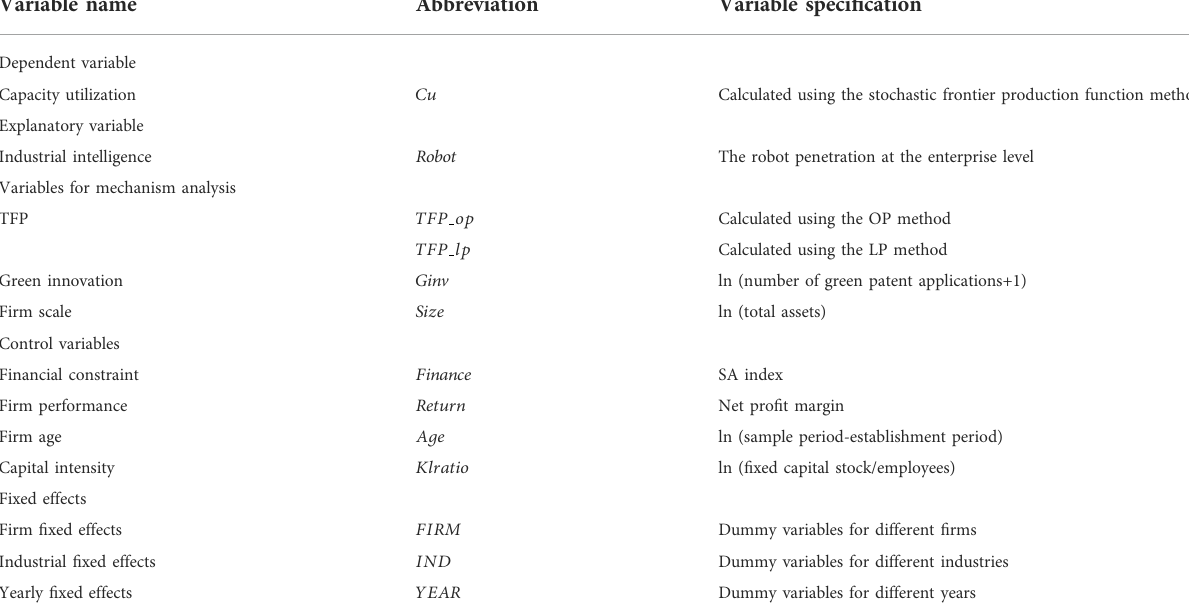
TABLE 2 De fi nition of variables.